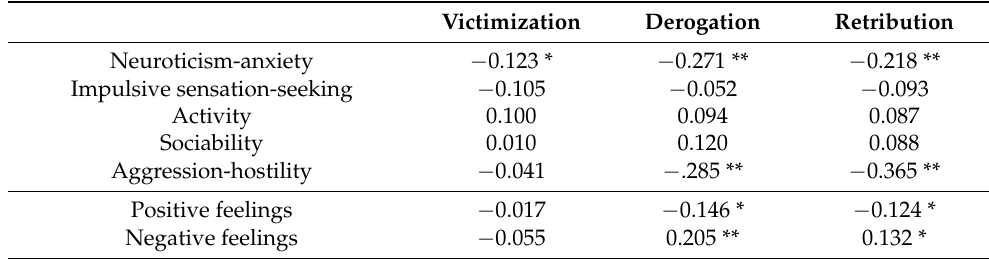
Table 5. Correlations with personality and emotional